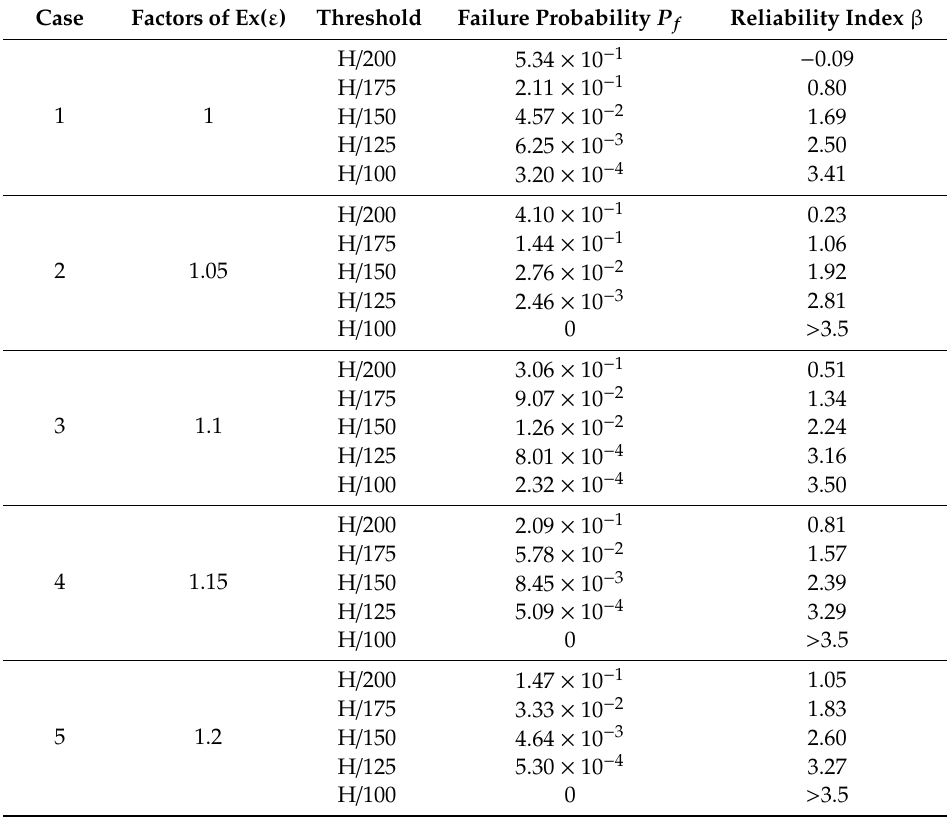
Table 6. Probabilistic results of di ff erent thresholds in five cases (5000 MCSs).